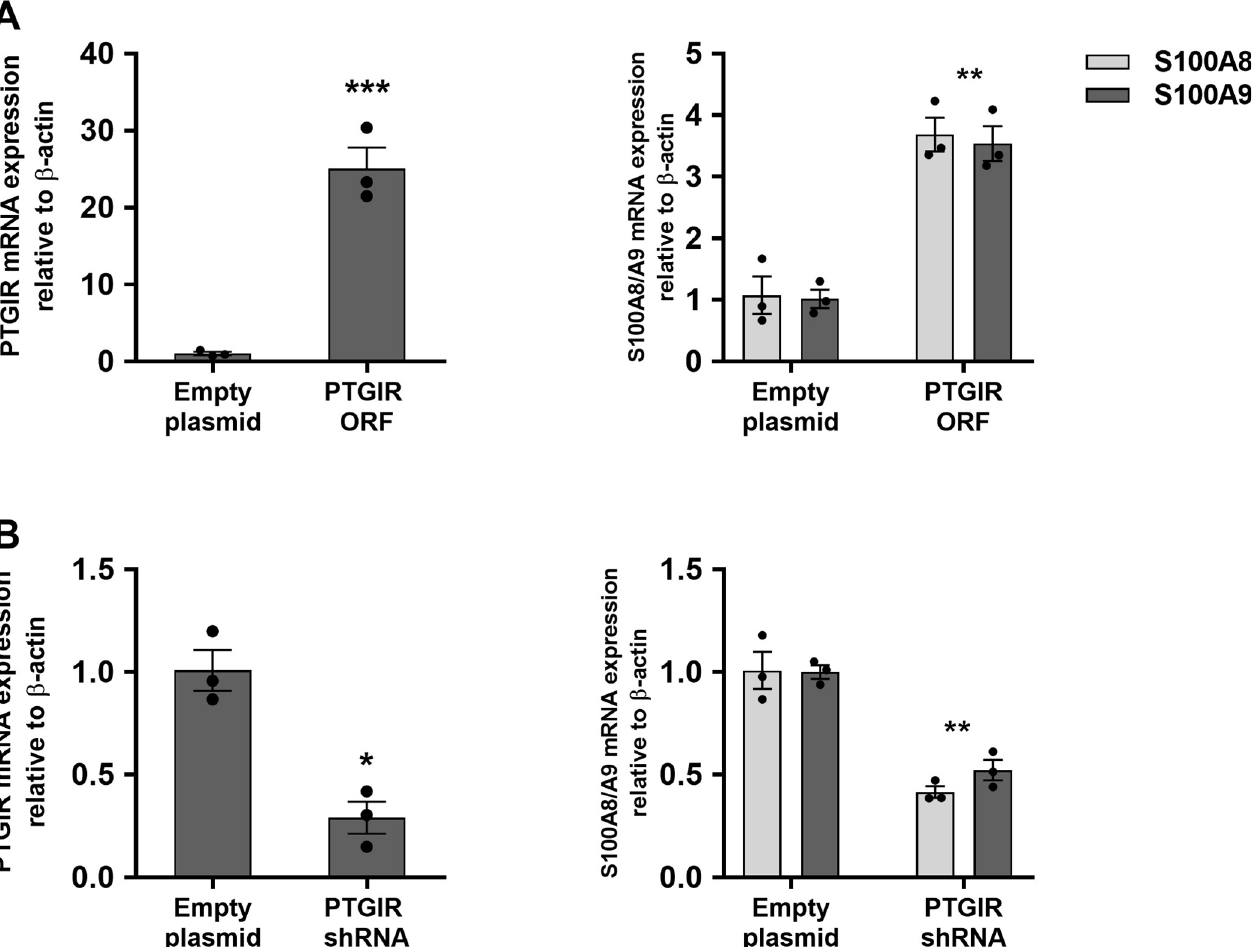
Fig 2. Impact of PTGIR expression and knockdown on S100A8/A9 genes expression in THP-1. (A) Relative mRNA expression levels of PTGIR and S100A8/A9 genes in THP-1 cell lines following transduction with lentiviruses containing either an empty plasmid or a plasmid encoding for the PTGIR ORF. (B) Relative mRNA expression levels of PTGIR and S100A8/A9 genes were evaluated in THP-1 cell lines following transduction with lentiviruses containing either an empty plasmid or a plasmid containing an shRNA targeting PTGIR ( PTGIR shRNA). Each bar is the mean of 3 samples from 3 different infections ± SEM. � P < .05, �� P < .01, ��� P < .001 (Student’s t -test unpaired).